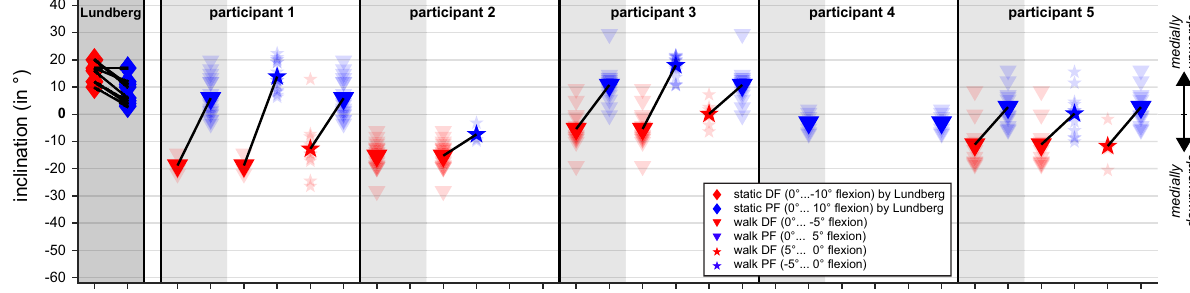
Figure 4. Inclination of ankle joint axes representative for dorsiflexion (red) and plantarflexion (blue). Diamonds represent inclinations of axes which Lundberg et al. 7 determined for quasi-static flexion in eight participants (black lines link related data). In our study, during the stance phase of walking, the ankle joint was for none of our participants once at least 10° dorsiflexed (i.e., − 10° flexion) and only once at least 10° plantarflexed (i.e., 10° flexion, see Fig. 1). Thus, we report here on joint axes inclinations derived from 5° flexion, either when 5° of dorsi/plantarflexion have been achieved from a joint configuration corresponding to the relaxed standing, i.e., 0° flexion (triangles), or when a joint configuration corresponding to the relaxed standing has been achieved again after a 5° dorsi/plantarflexion position (pentagrams). Inclinations of individual trials, if the axis could be determined, are shown more transparently, mean values per participant and comparison of dorsiflexion and plantar flexion are connected with a black